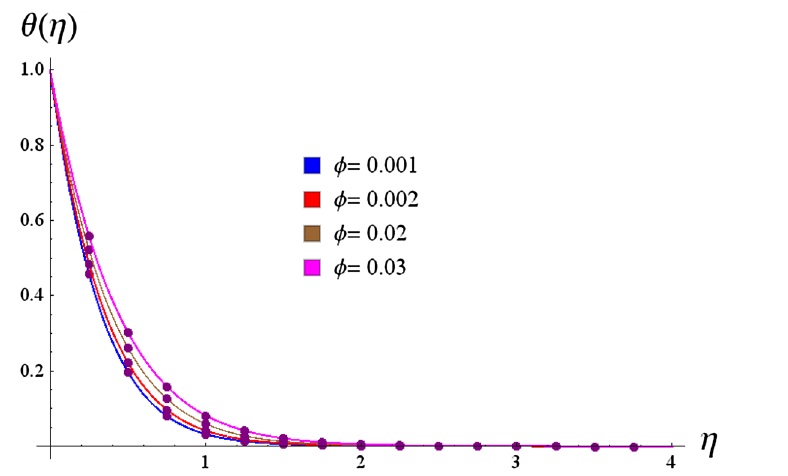
Figure 8. Behavior of temperature θ(η) against φ = 0.001, 0.002, 0.02,